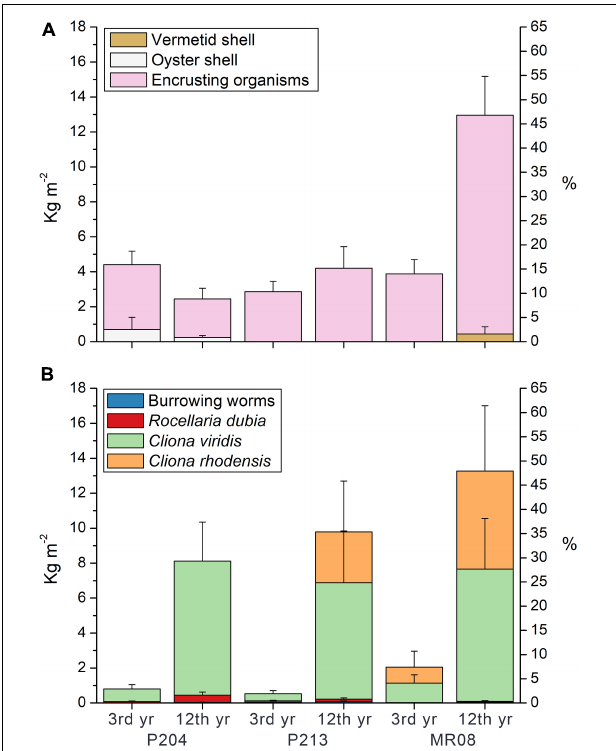
FIGURE 3 | Mean ( ± s.e.) limestone deposited (A) and eroded (B) per area (kg m − 2 ) by different organisms at each study sites (P204, P213, MR08) and per exposure times (3 and 12 years) measured in the experimental tiles. Percentage axes represent the relative contribution to the bioconstruction and bioerosion, in volume, compared to the initial size of the experimental